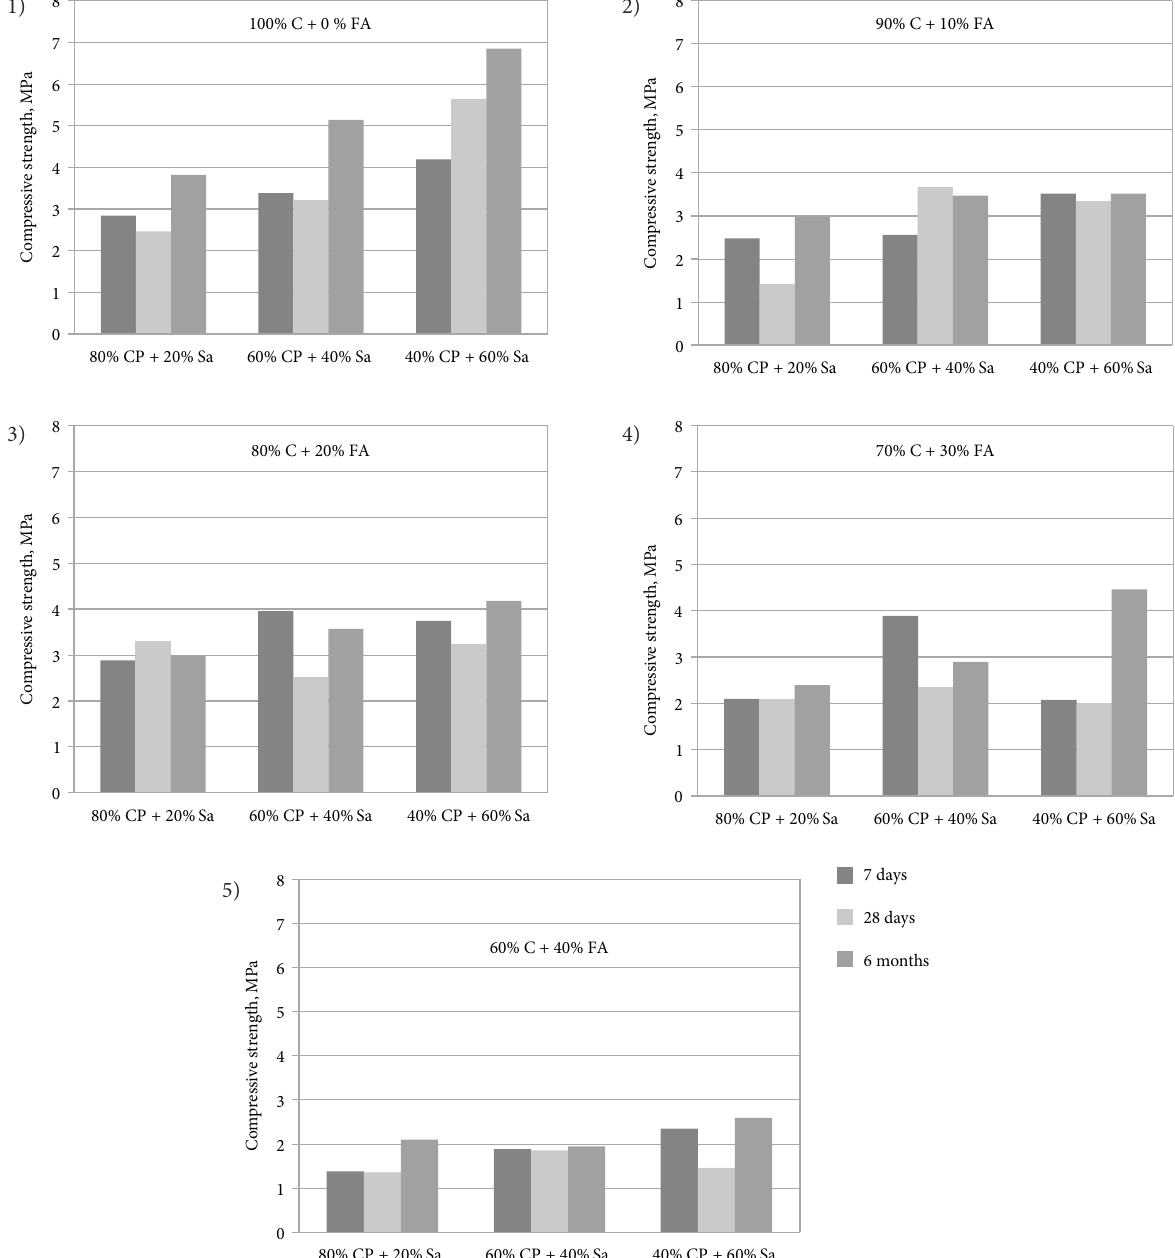
Figure 5. Сompressive strength of samples: 1 – 100% C + 0% FA; 2 – 90% C + 10% FA; 3 – 80% C + 20% FA; 4 – 70% C + 30% FA; 5 – 60% C + 40%